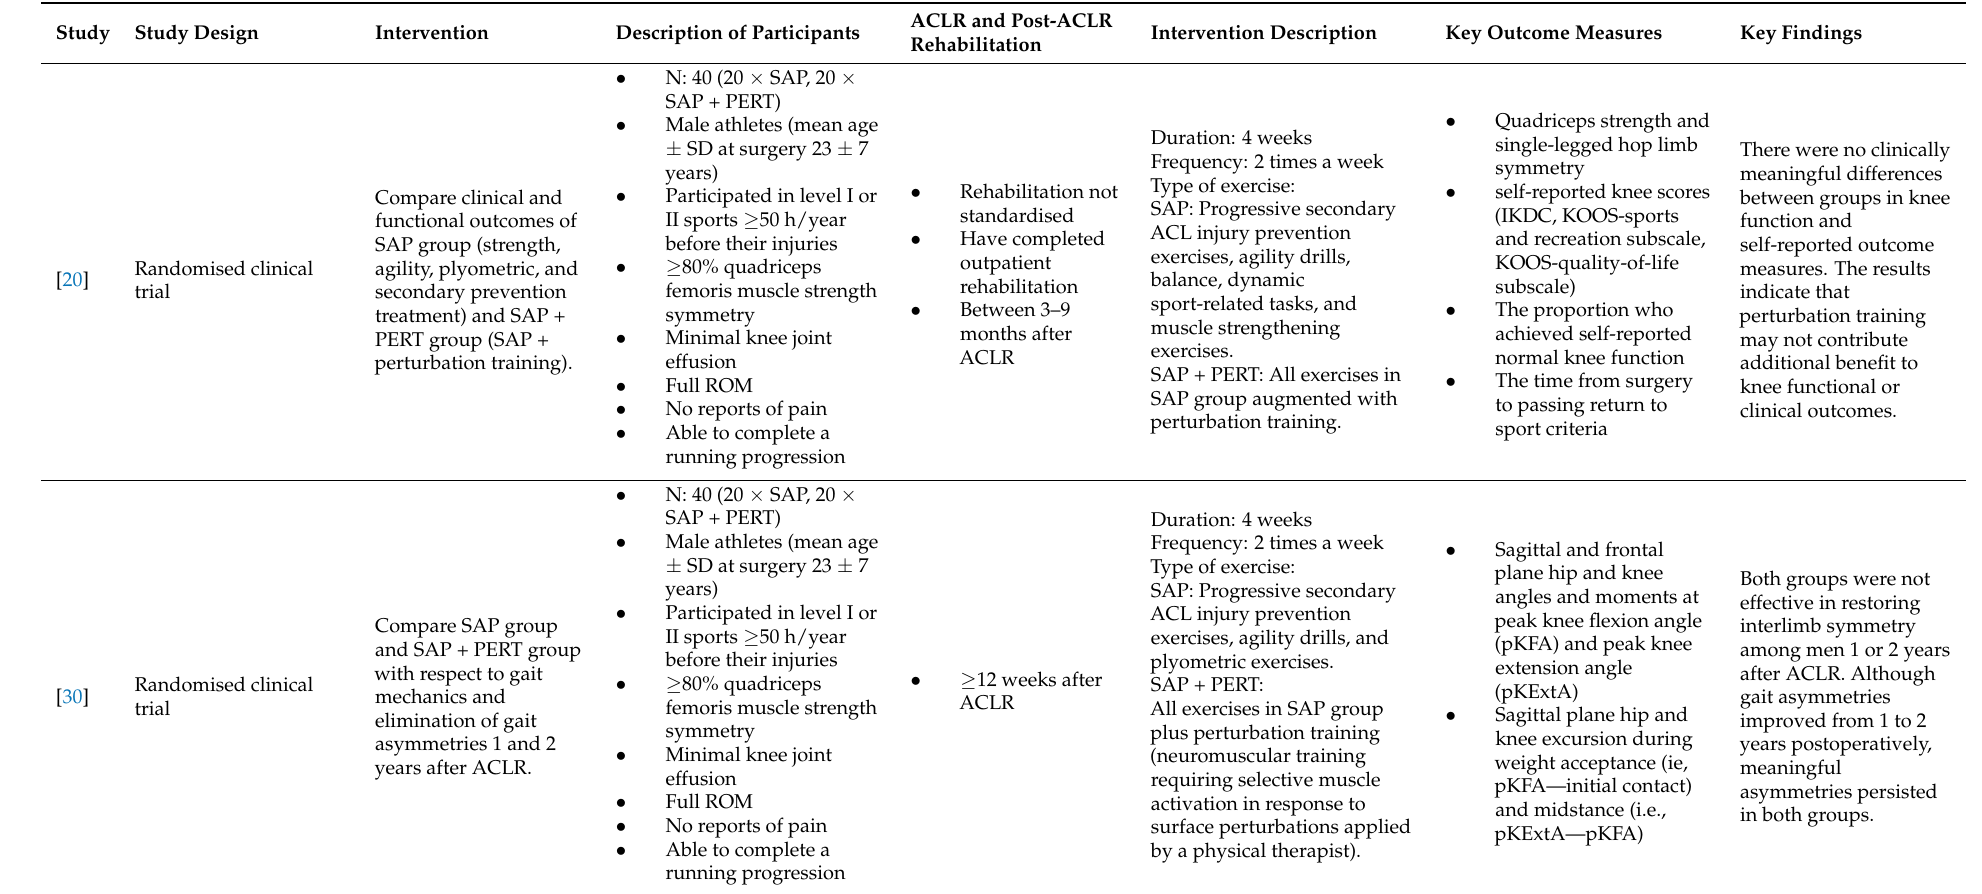
Table 1. Summary of the included